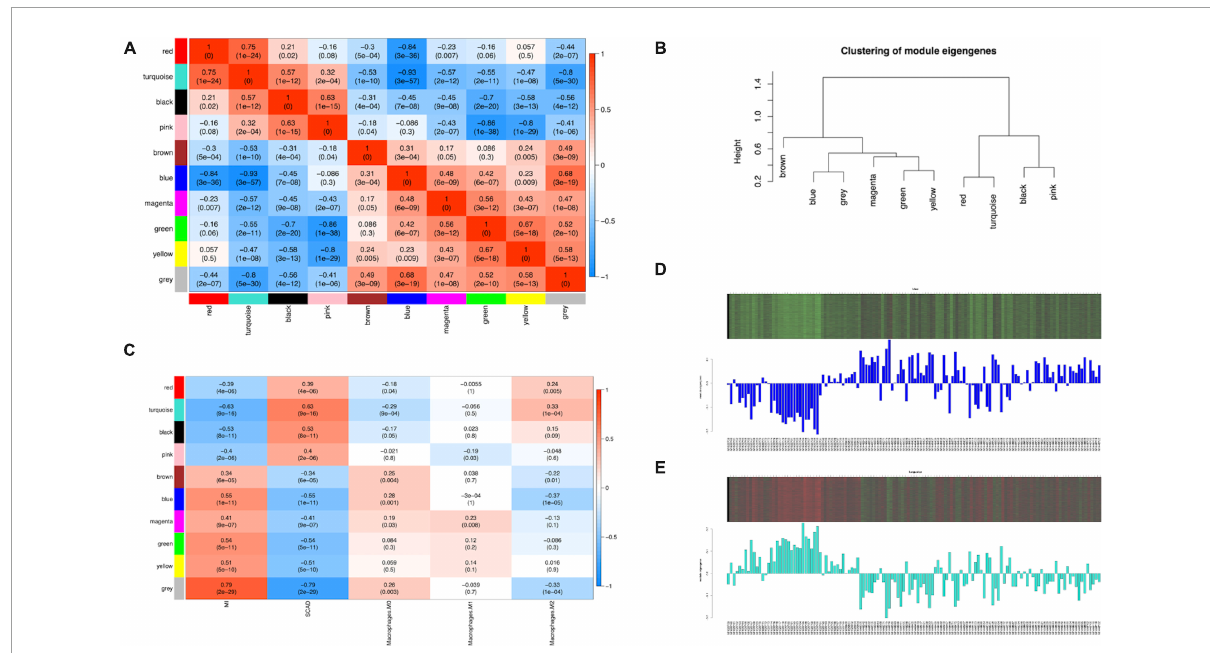
FIGURE4 Consensus eigengene networks and their differential analysis. (A) Heatmap of the eigengene networks, red indicates positive correlation, and blue indicates negative correlation, the absolute value means the degree of adjacency with other modules. (B) The clustering trees (also called the dendrograms) of the consensus module eigengenes; (C) Relationship between consensus module and feature. Correlation analyses were conducted between clinical features and eigengene values represented for each module. The numbers in the matrix cell indicate the correlation coefficient and the related p -value. The blue module was most negatively related to M φ 2, and the turquoise module was most positively correlated to M φ 2. (D,E) The expression level of all samples in genes of blue (D) and turquoise (E) modules. In the heatmap, green indicates the low expression for samples, whereas red indicates the high expression, which means ME is strongly related with expression of genes in